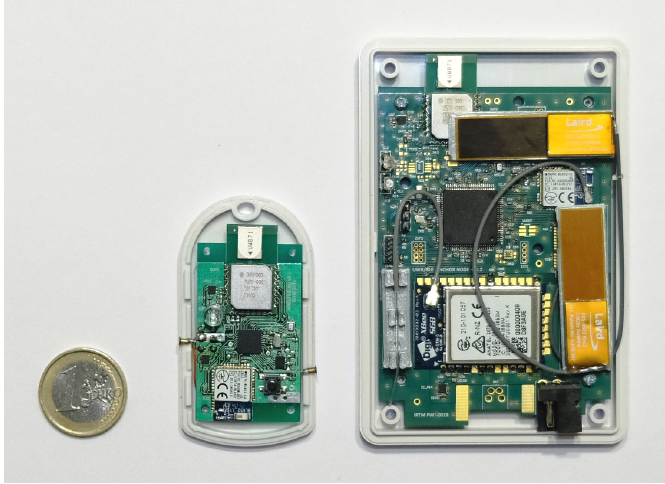
Figure 2. Localization system devices: the tag and the anchor